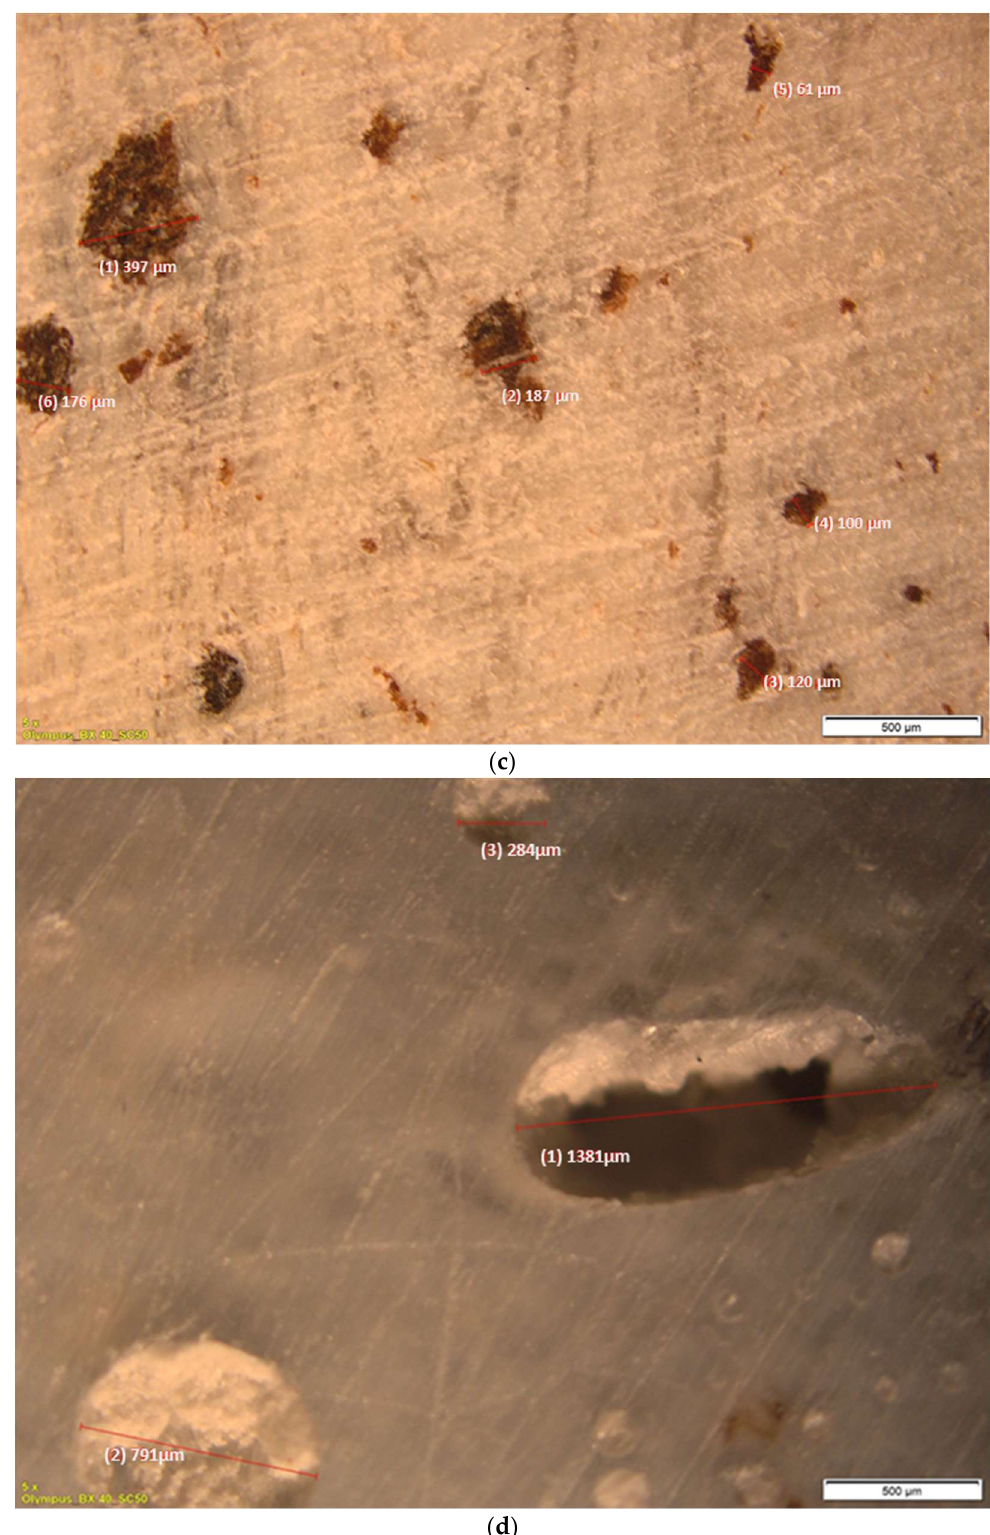
Figure 14. ( a ) Optical microscopy test image of plasticized PLA–WS with 10% filler composite at 500 µm scale. ( b ) Optical microscopy test image of plasticized PLA–WS with 15% filler composite at 500 µm scale. ( c ) Optical microscopy test image of plasticized PLA–WS with 20% filler composite at 500 µm scale. ( d ) Optical microscopy test image of plasticized PLA–ES with 10% filler composite at 500 µm scale.